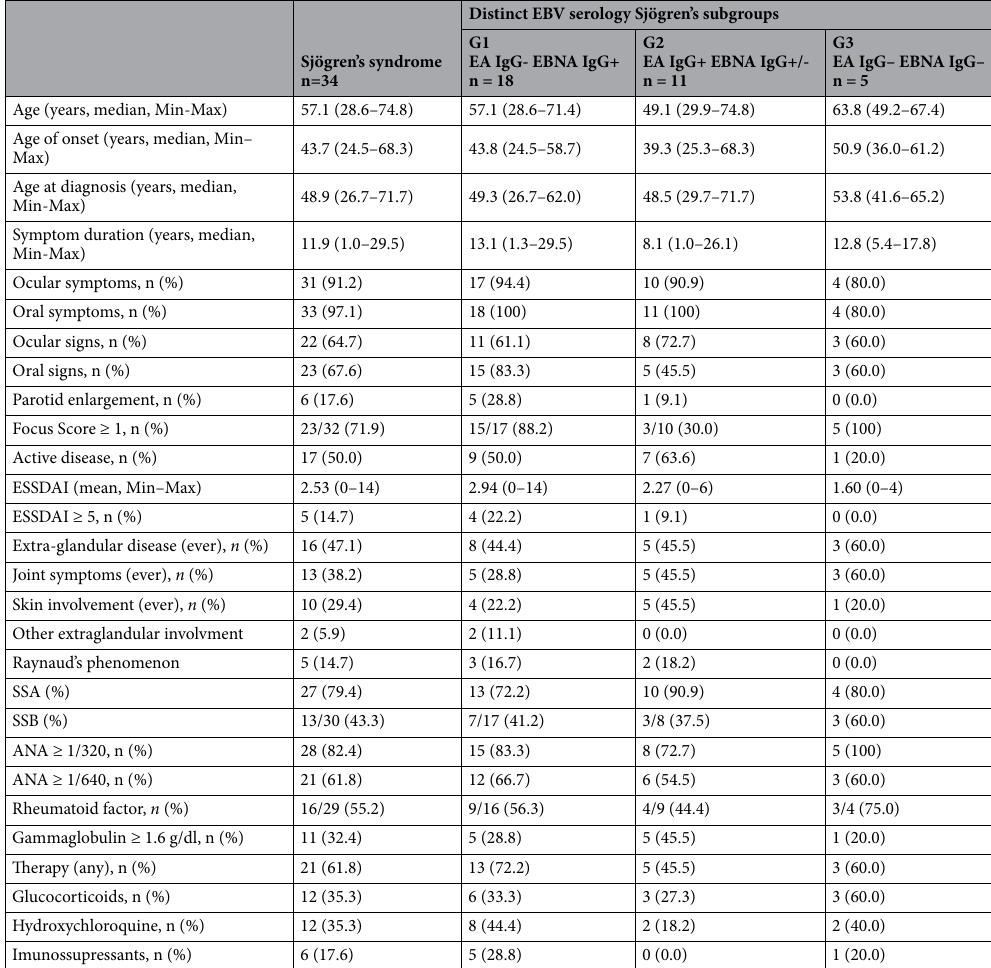
Table 3. Characterization of SjS patients and of SjS subgroups with distinct EBV serology. Patient’s characteristics are represented as number of occurrences (n) and percentages (%). Whenever there were missing values, percentages reflect the number of occurrences over the number of patients tested for the item. Ocular evaluation included Schirmer’s test and corneal staining score. The oral signs item consisted of a decreased unstimulated salivary flow. Focus score was defined as the number of lymphocyte aggregates (≥ 50 cells) per 4 mm 2 of glandular area of the biopsy sample. Joint symptoms include arthritis and joint pain of inflammatory origin, but only cases that would score in the articular domain of ESSDAI were considered as extra-glandular disease. Likewise, in some patients skin involvement (which not included xerosis) was not considered as extra-glandular disease if it would not score in the cutaneous domain of ESSDAI. Clinically active disease was defined as activity in any ESSDAI domain, except the hematologic and biologic. SjS